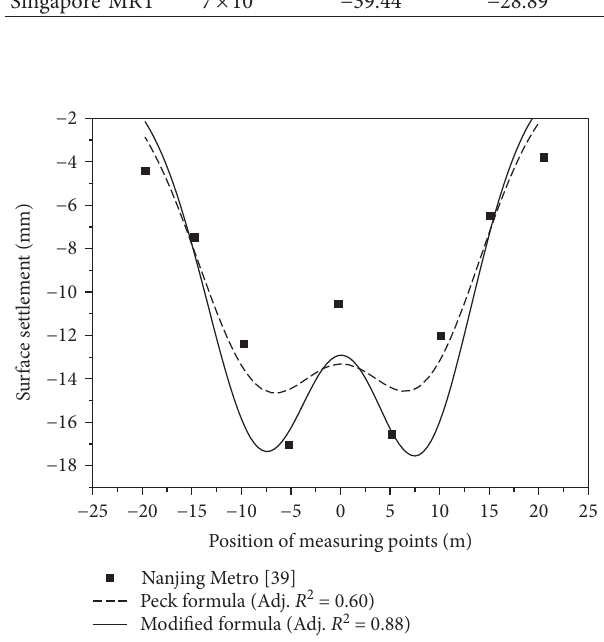
Figure 14: Surface settlement of Nanjing Metro.